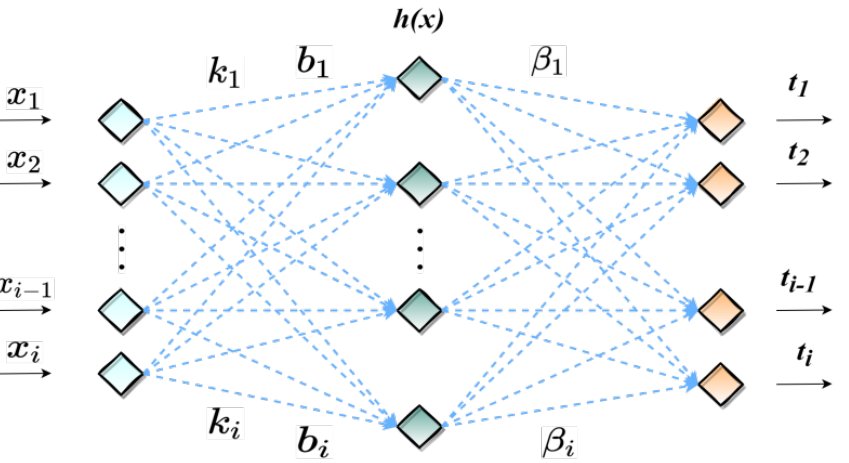
Figure 4. Schematic diagram of the ELM structure.